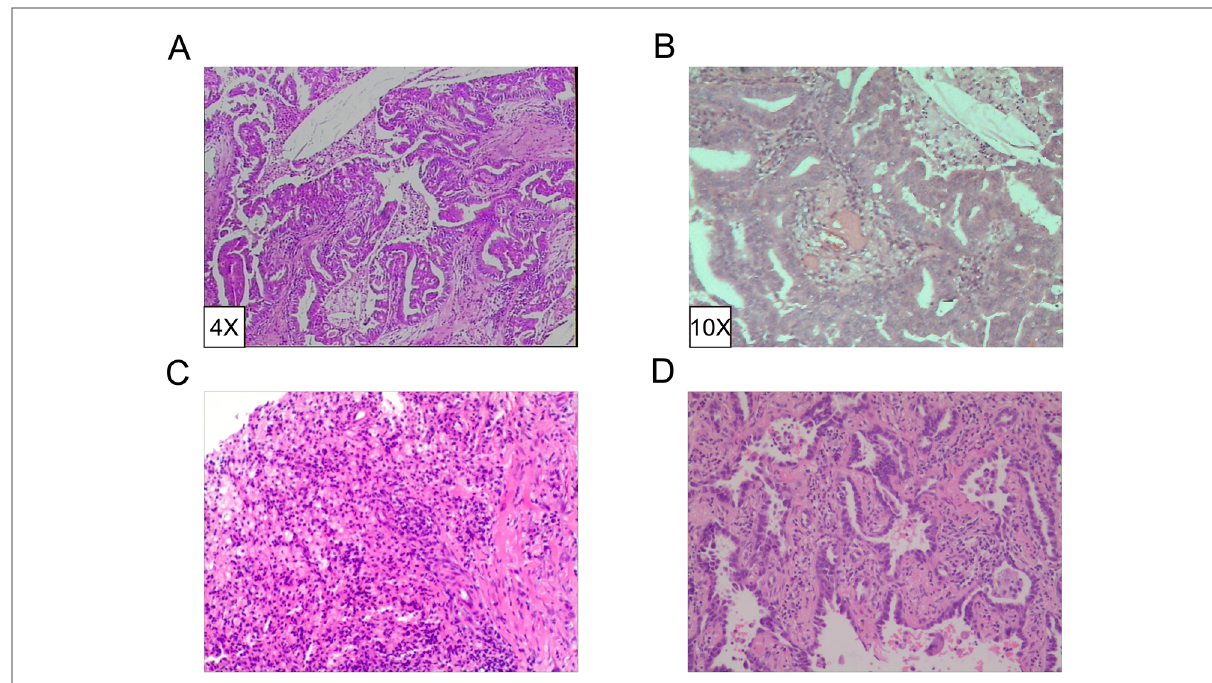
FIGURE 3 Pathological diagnosis of lesions. ( A,B ) Invasive adenocarcinoma grade II-III (alveolar dominant type). IHC revealed CK7+, CK5/6-, P63+, CK51+, TTF1+, SPA+, P16+, ER+(20%), PR+(10%), DOG1-. (HE4X/10X). ( C ) Chronic granulomatous in fl ammation with mechanization. ( D ) Invasive non- mucinous